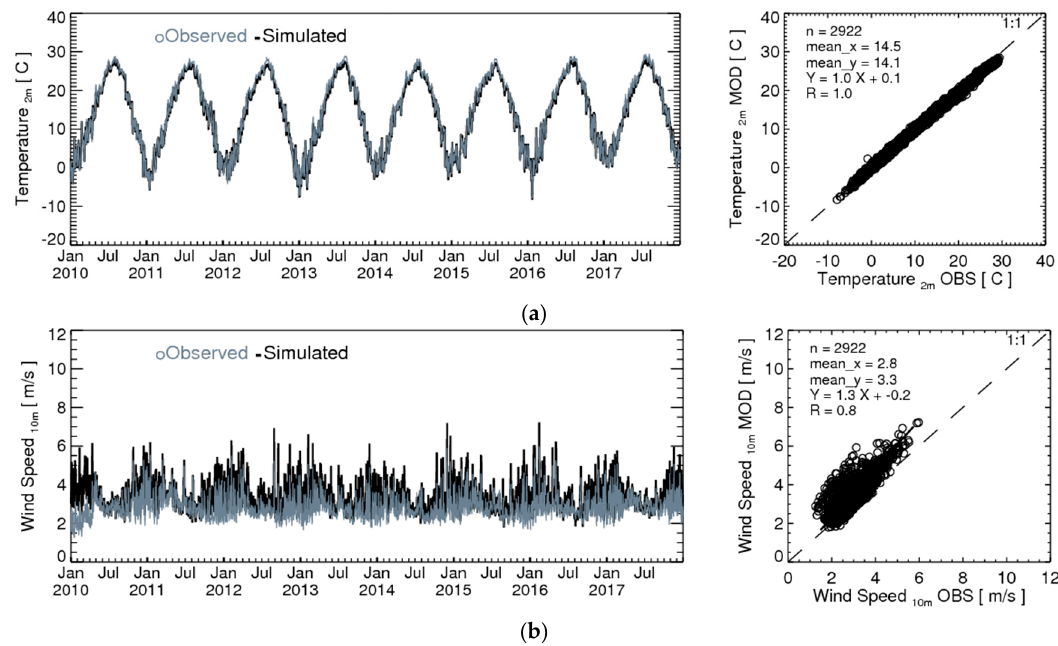
Figure 2. Comparisons of observed and simulated daily mean values of ( a ) 2-m temperatures and ( b ) 10-m wind speeds. These values were spatially averaged over 98 METeorological Aerodrome Reports (METAR) sites in South Korea and China.